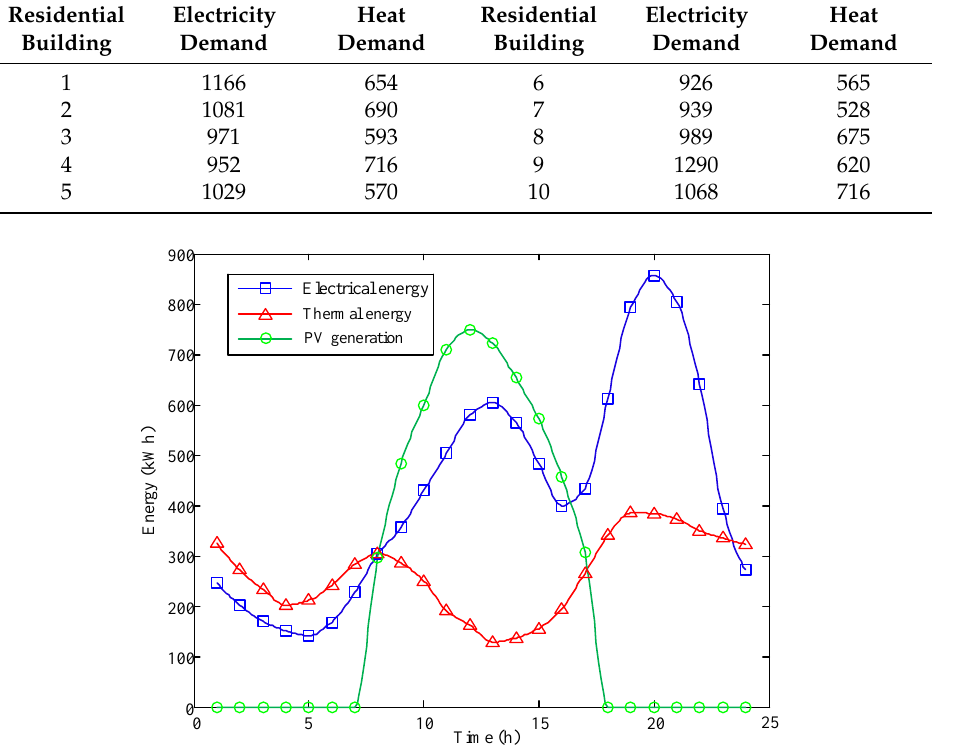
Figure 2. Typical loads and energy output of